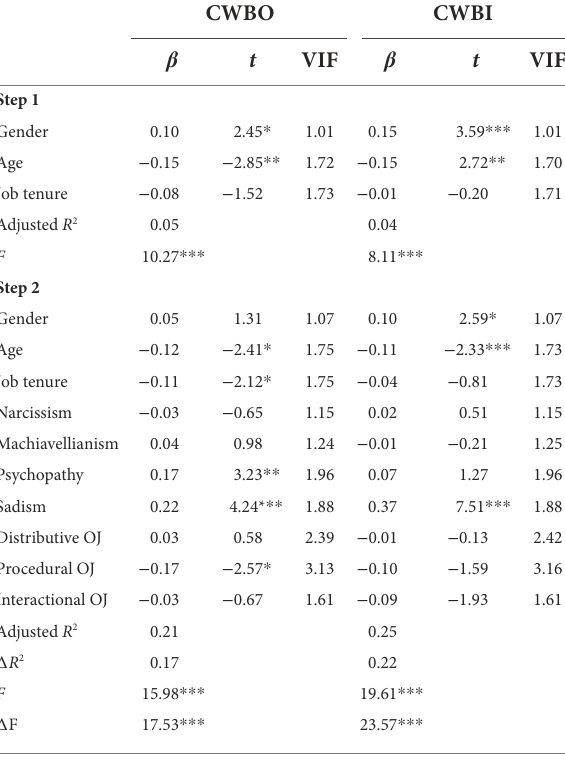
TABLE 2 Results for hierarchical regression analyses for CWBO and CWBI.